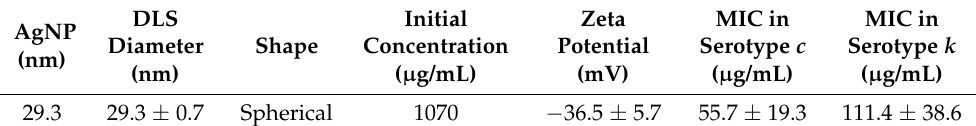
Table 1. Characteristics of AgNP used in the